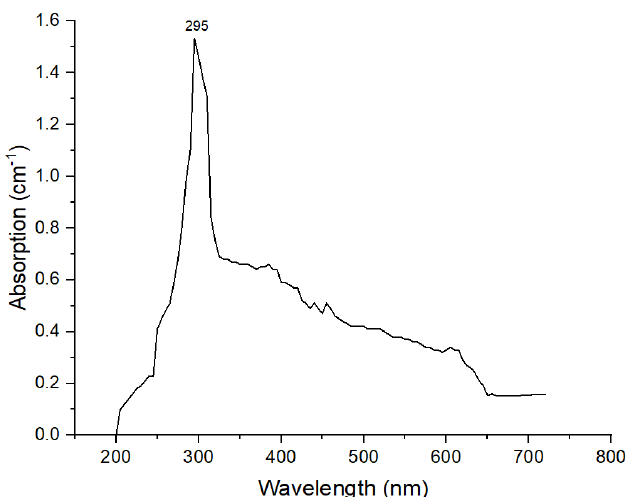
Figure 1. UV spectra of TiO 2 NPs.